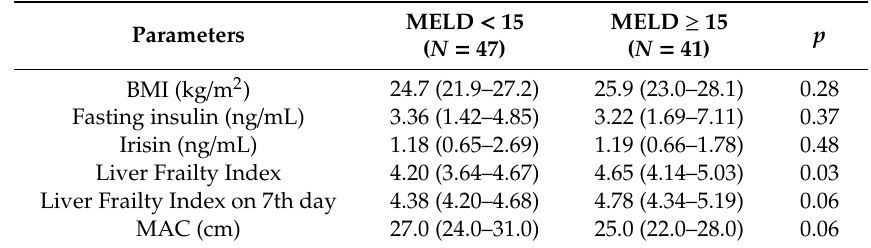
Table 5. Analyzed parameters with regards to the severity of cirrhosis, as evaluated according to the model for end-stage liver disease (MELD)